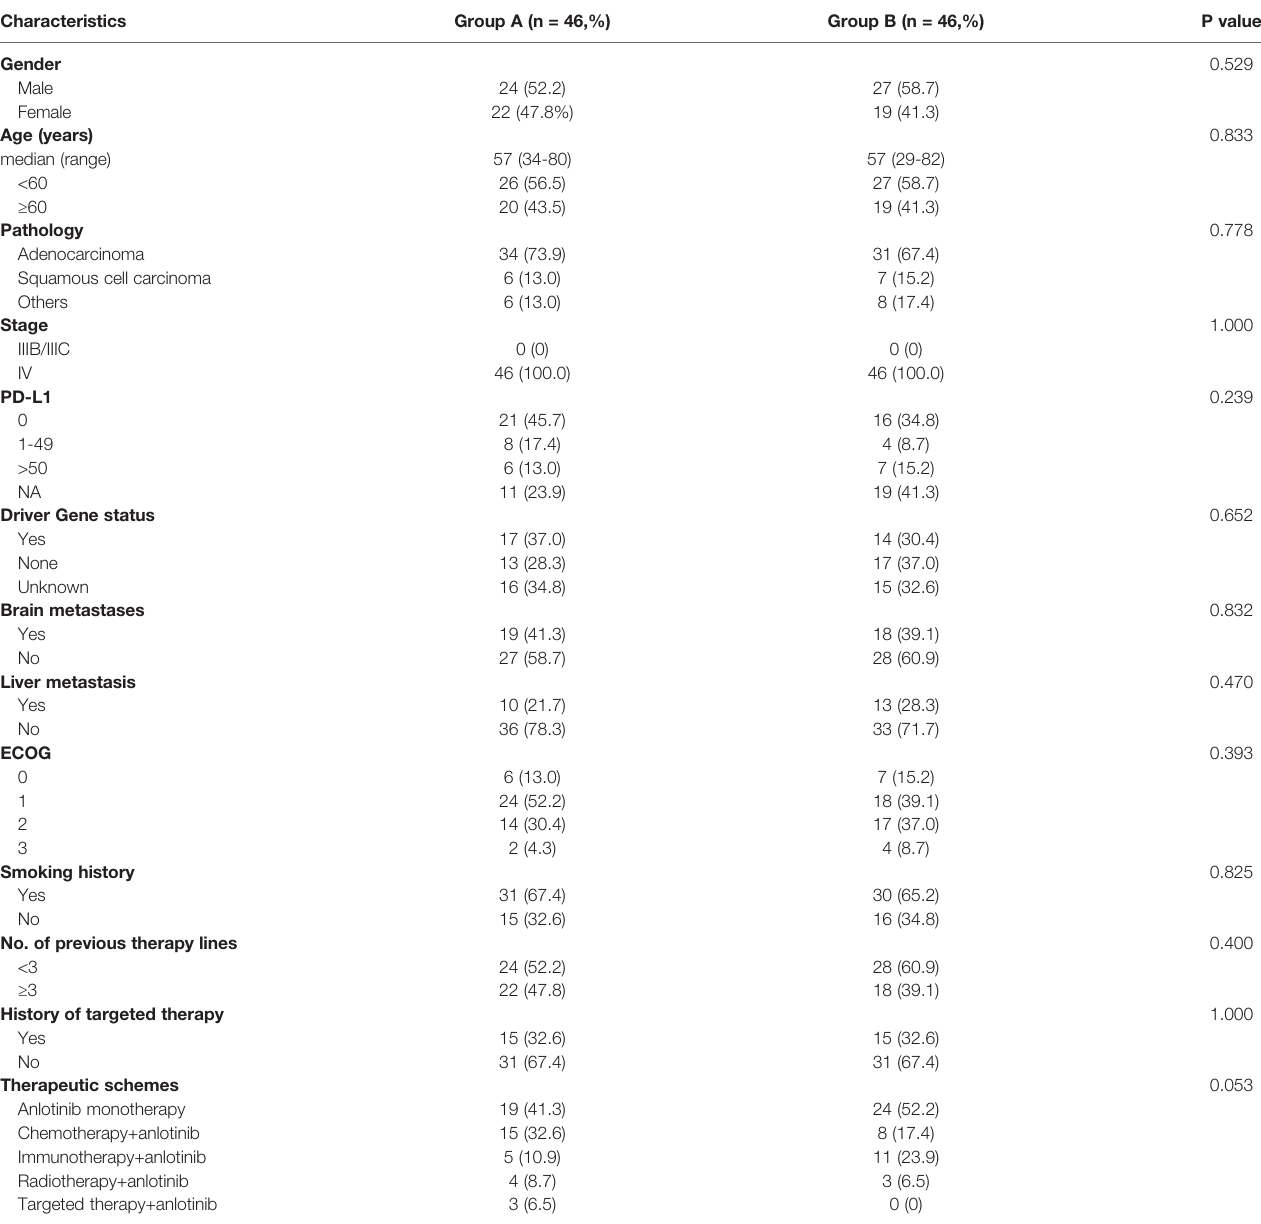
TABLE 2 | Comparison of baseline characteristics of patients after 1:1 matching of propensity score matching. Characteristics